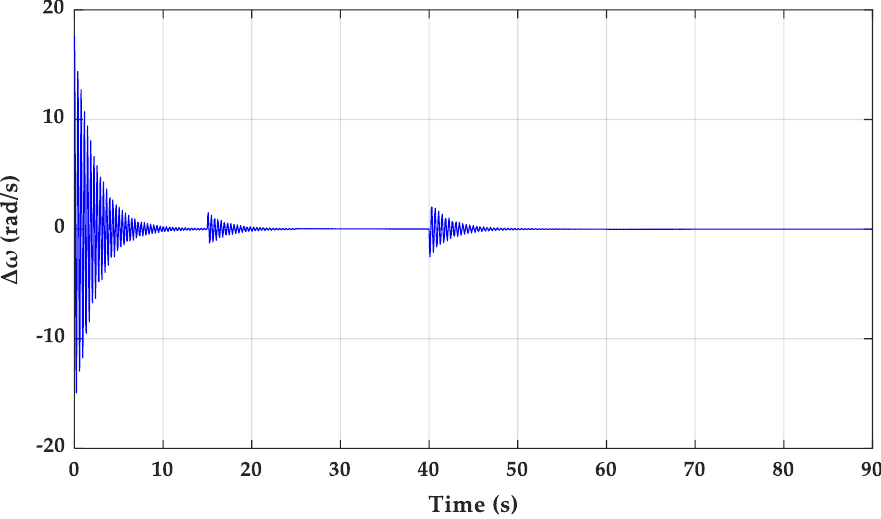
Figure 10. Response of the angular speed of the SGIB with feedback. Energies 2020 , 13 , x FOR PEER REVIEW